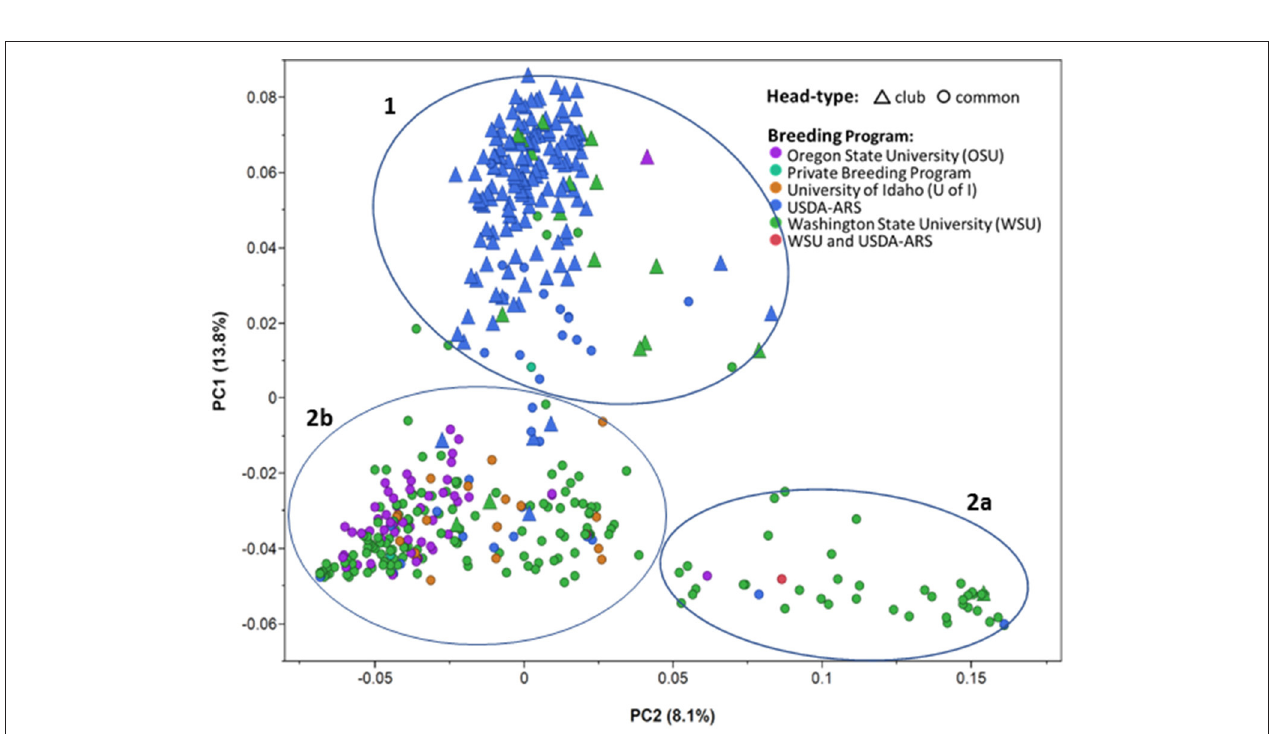
FIGURE 3 | Principal component analysis (PCA) of a soft white winter wheat diversity panel using 15,229 SNP markers from all genomes showing two major sub-populations representing head type: club (1) or lax from (2) wheat breeding programs in the PNW. The lax form group can be further subdivided into two groups (2a,b) . The phenotypic variation explained by each PC axis are as follows: PC1 = 13.8% and PC2 = 8.1%.